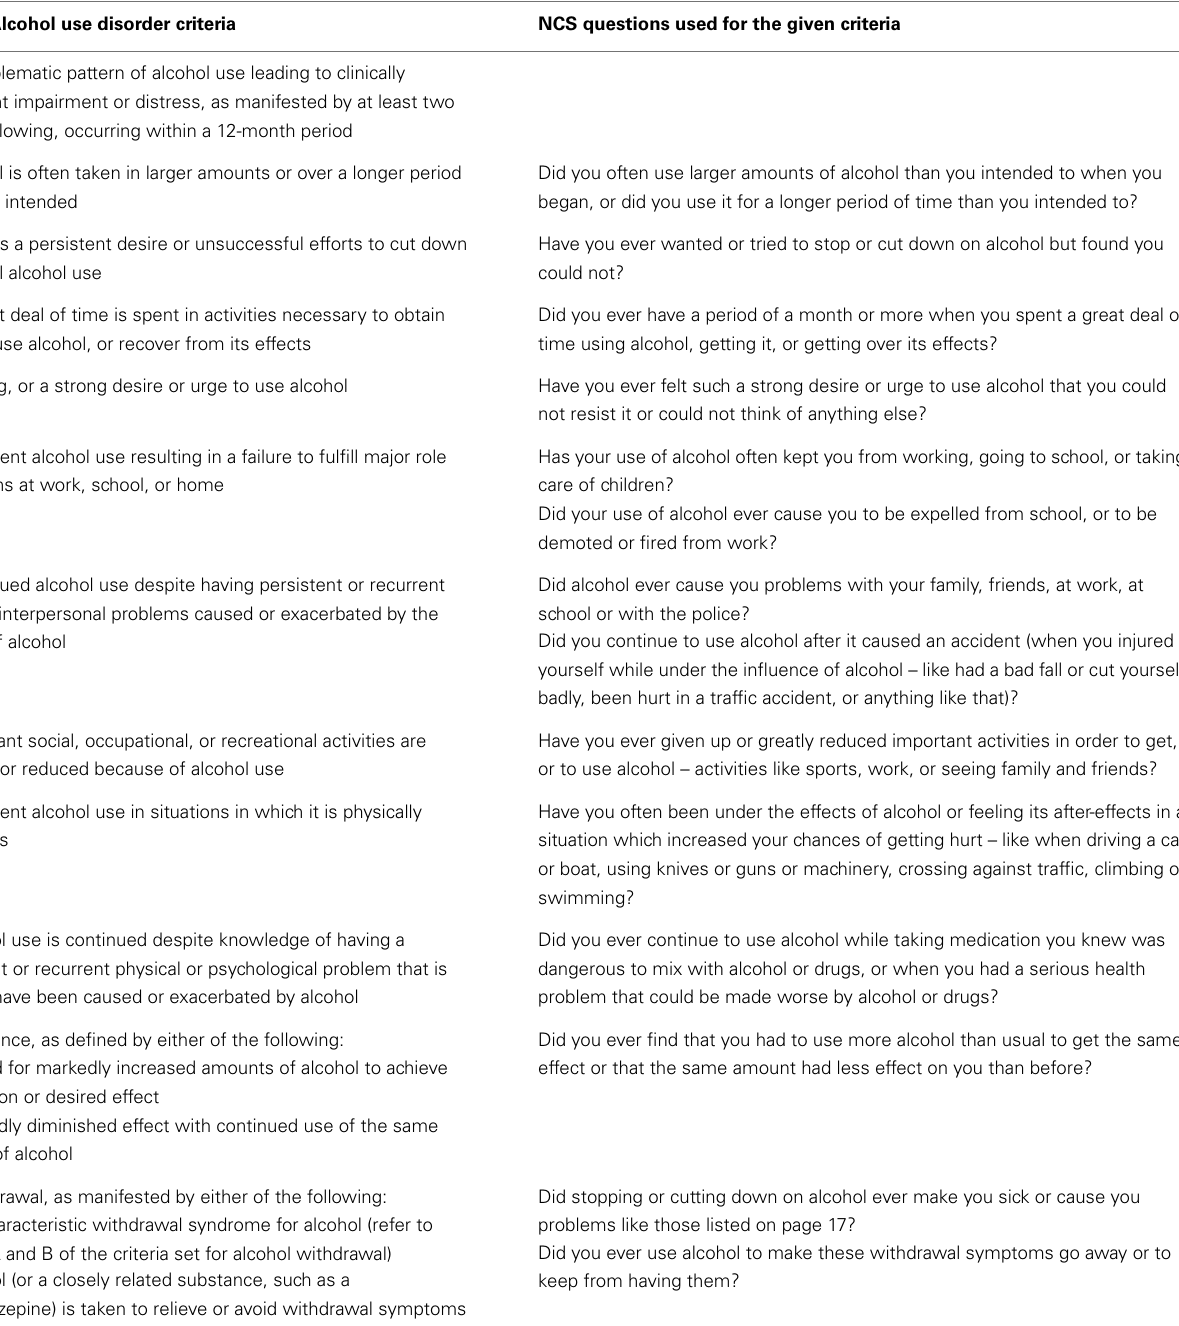
TableA5 | DSM-5 diagnostic criteria for alcohol use disorder and their translation using National Comorbidity Survey (NCS) questions